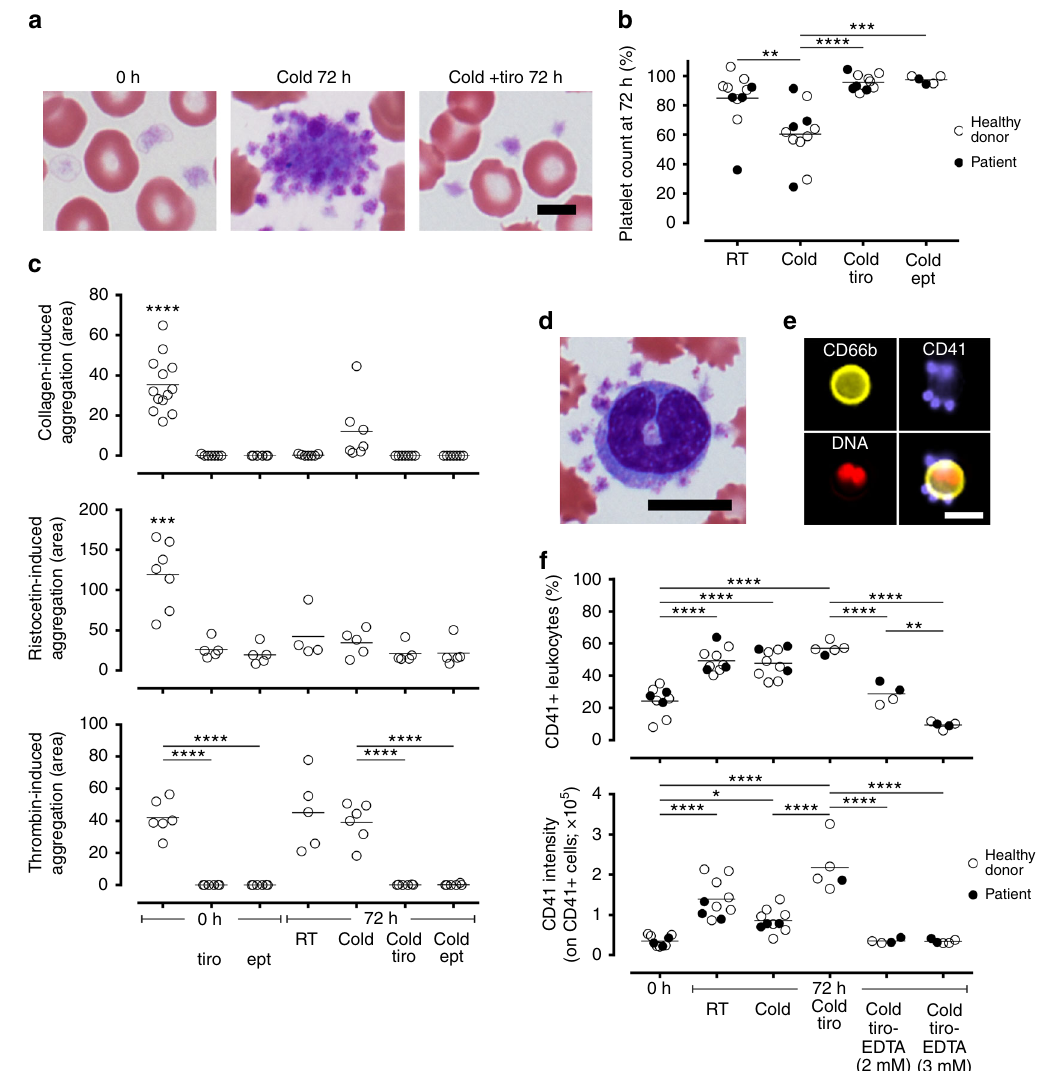
Fig. 2 Platelet stabilization with GPIIb/IIIa inhibitors and calcium chelation. a Representative images of platelets demonstrating cold-induced aggregation, which is inhibited by tiro fi ban (tiro; 0.5 μ g mL − 1 ). b Changes in platelet count as a result of storage in the presence of tiro fi ban or epti fi batide (ept; 50 µ g mL − 1 ), or without any inhibitors. A decrease in count relative to 0 h indicates aggregation. c Platelet aggregation induced by collagen, ristocetin, and thrombin in both fresh and stored blood (with or without inhibitors) measured by impedence aggregometry. d A representative image of platelet cloaking in stored blood. e , f Platelet cloaking quanti fi ed by imaging fl ow cytometry. f CD41+ leukocytes are cells that are positive for at least one platelet. CD41 intensity quanti fi es the extent of platelet attachment on these cells. Scale bar in a represents 5 μ m. Other scale bars represent 10 μ m. * p < 0.05; ** p < 0.01; *** p < 0.001; **** p < 0.0001 (one-way ANOVA followed by Tukey ’ s post — for example, low temperatures used for red blood cell (RBC)